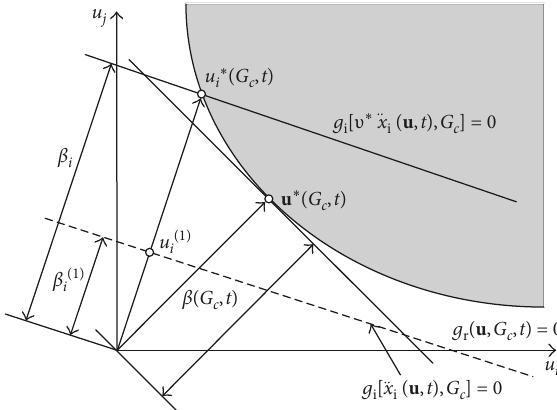
Figure 3: Design point determining using the linear correction idealized